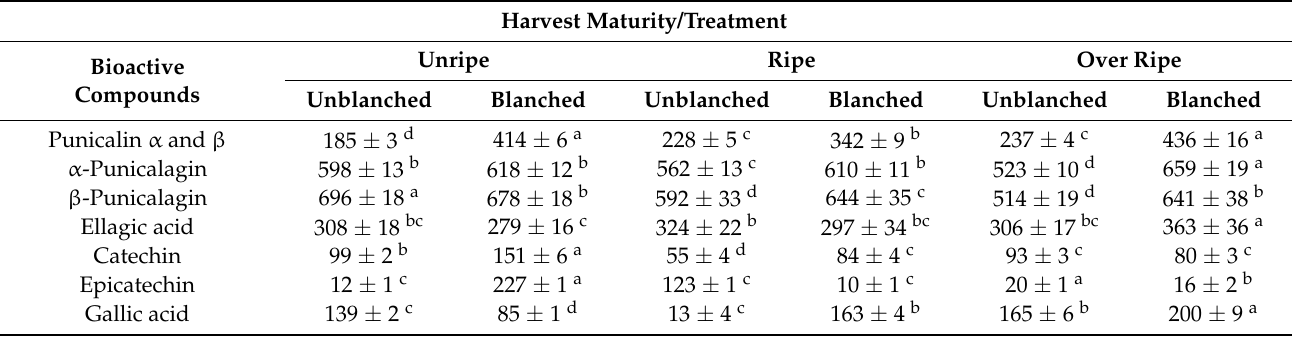
Table 2. Individual phenolic and flavonoid concentration from three harvest maturities (unripe, ripe, and over ripe) of ‘Wonderful’ pomegranate peel blanched at 80 ◦ C for 3